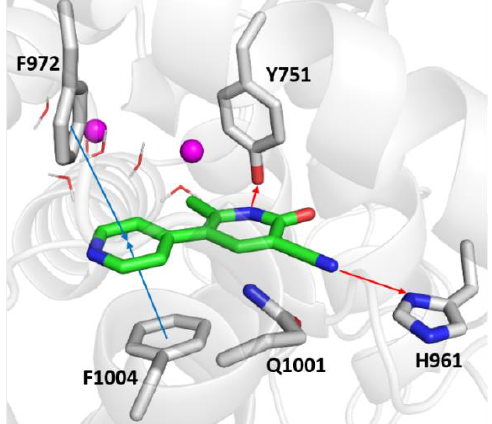
Figure 7. Zoomed in view of the PDE3A binding site. Milrinone is rendered as green sticks in the representation, the most relevant residues are reported as gray sticks, the magnesium ions are indicated as violet spheres, and the water molecules are depicted as wireframes. The red and blue arrows indicate the hydrogen bonds and the π - π interactions.